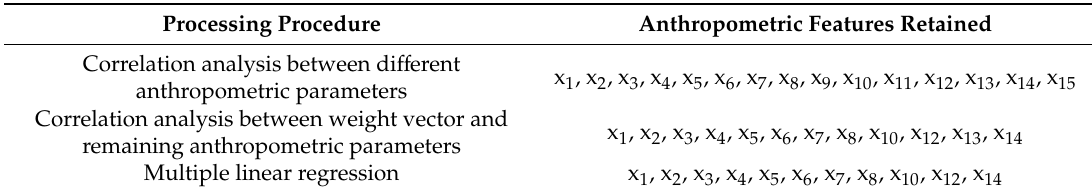
Table 2. Anthropometric features retained after each processing